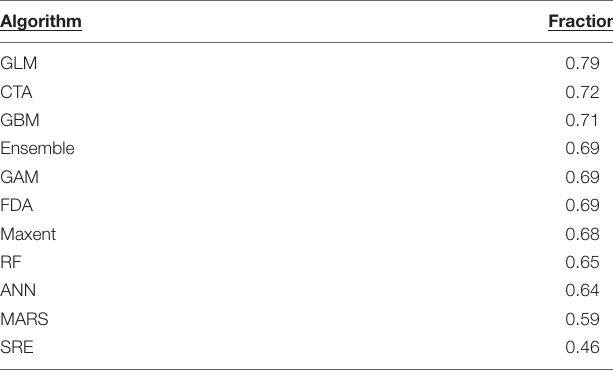
TABLE 1 | Fraction of predictions to novel regions in which species distribution models performed better than random (AUC greater than 0.5).